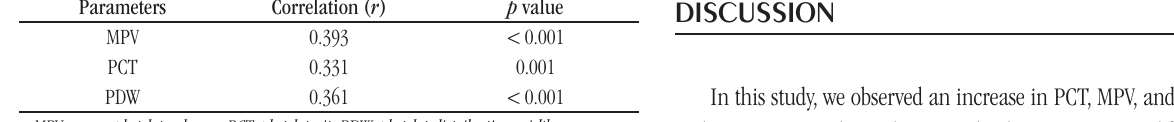
taBLE 3 – Pearson correlation for the association between platelet parameters and glycated hemoglobin in diabetic patients Parameters